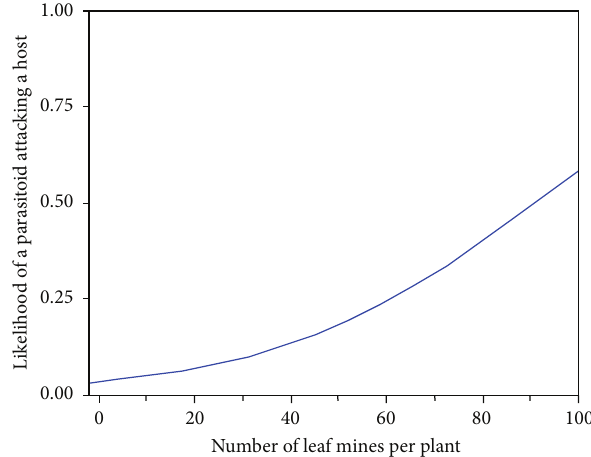
Figure 5: Relationship between leaf mine density on an onion plant and likelihood of a female Neochrysocharis okazakii successfully finding a host on that plant. A logistic regression curve is illustrated. Data plots are not shown for